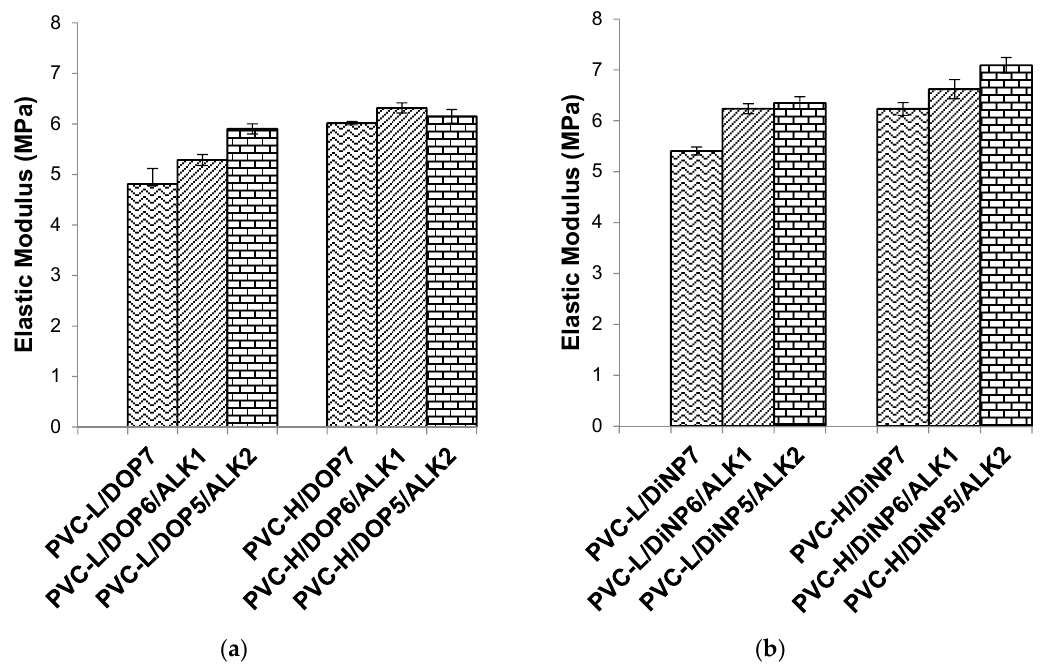
Figure 4. Effect of palm oil-based alkyd on the elastic modulus of ( a ) PVC/DOP blend and ( b ) PVC/DiNP blend.